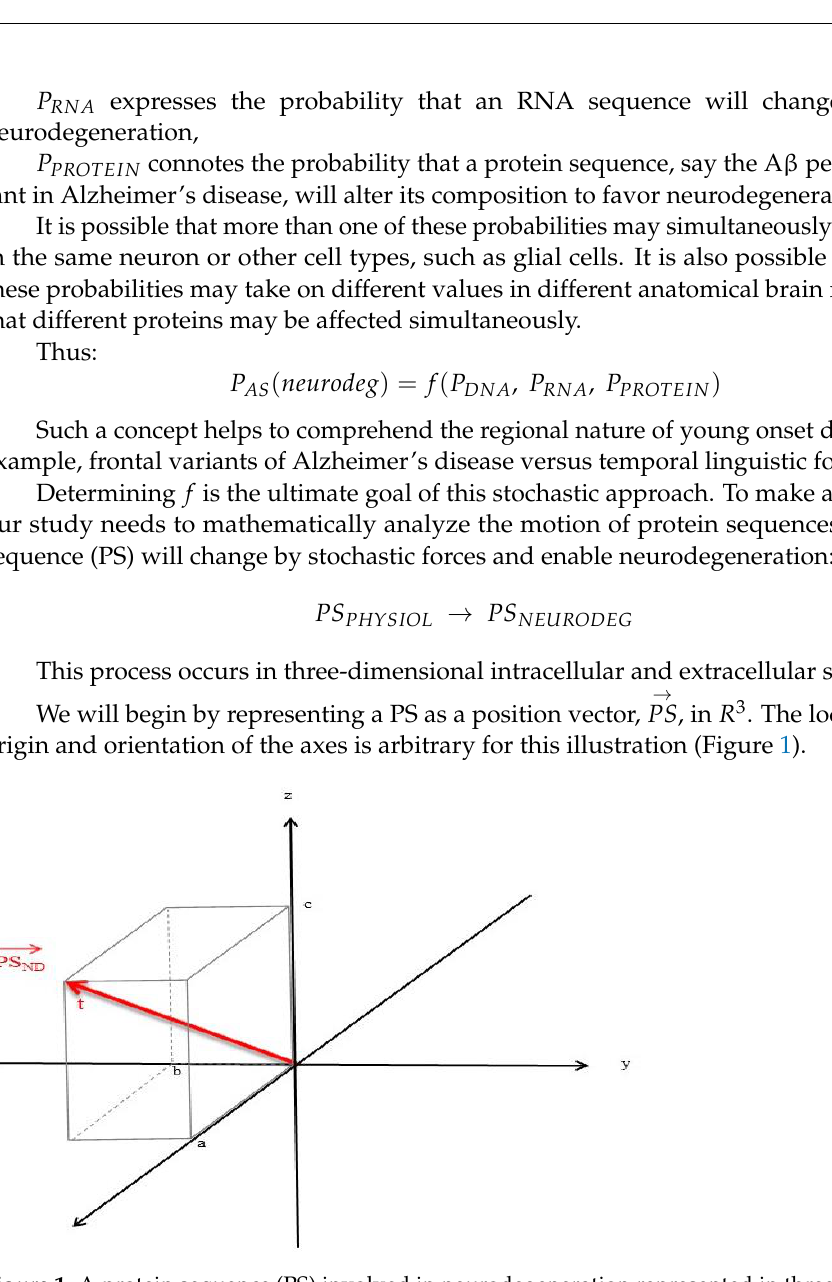
Figure 1. A protein sequence (PS) involved in neurodegeneration represented in three-dimensional space and time.